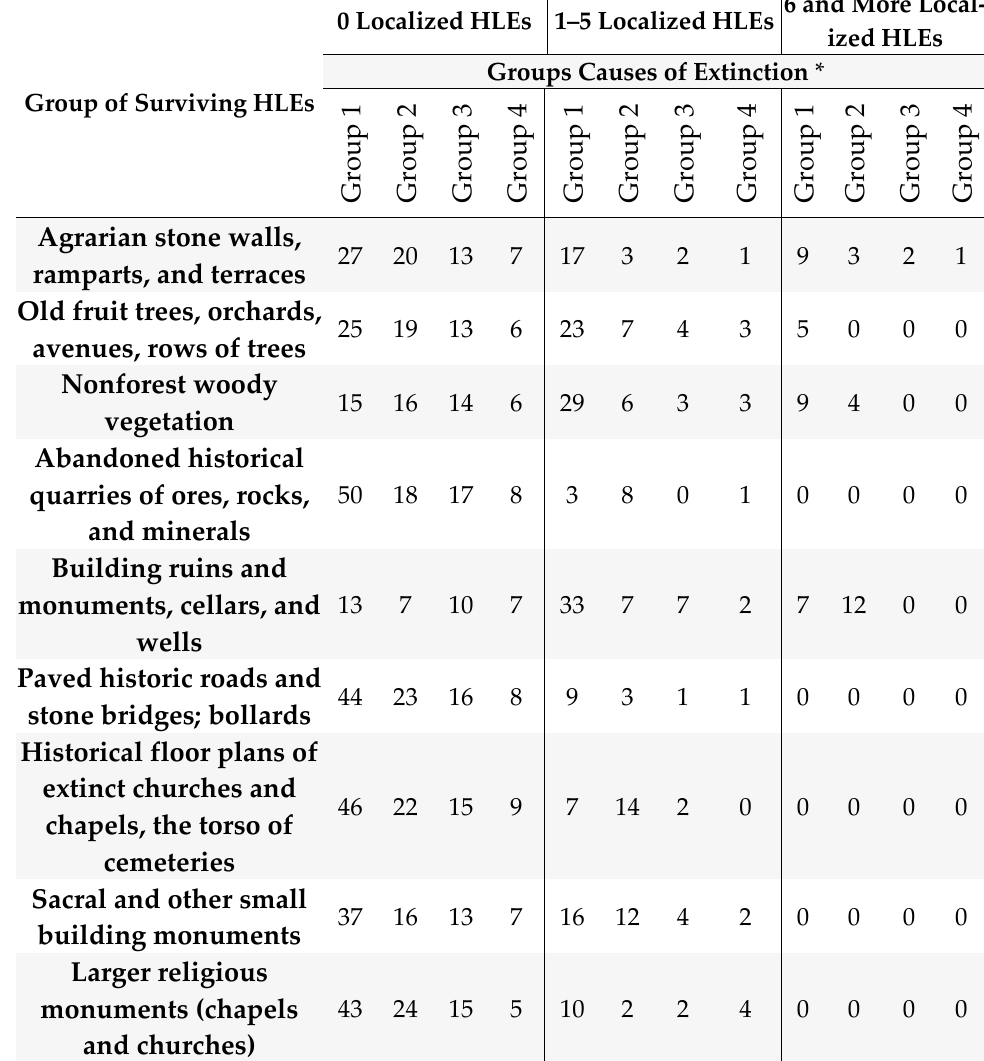
Table 2 summarizes the frequency of elements in HLE groups (divided into intervals), on the number of locations divided into the cause of the settlement’s extinction. Table 2. Summarization of HLE counts for the cause of extinction. Table 2. Summarization of HLE counts for the cause of extinction.